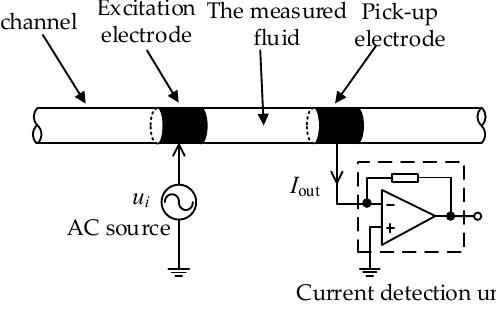
Figure 1. Basic structure of the C 4 D sensor.